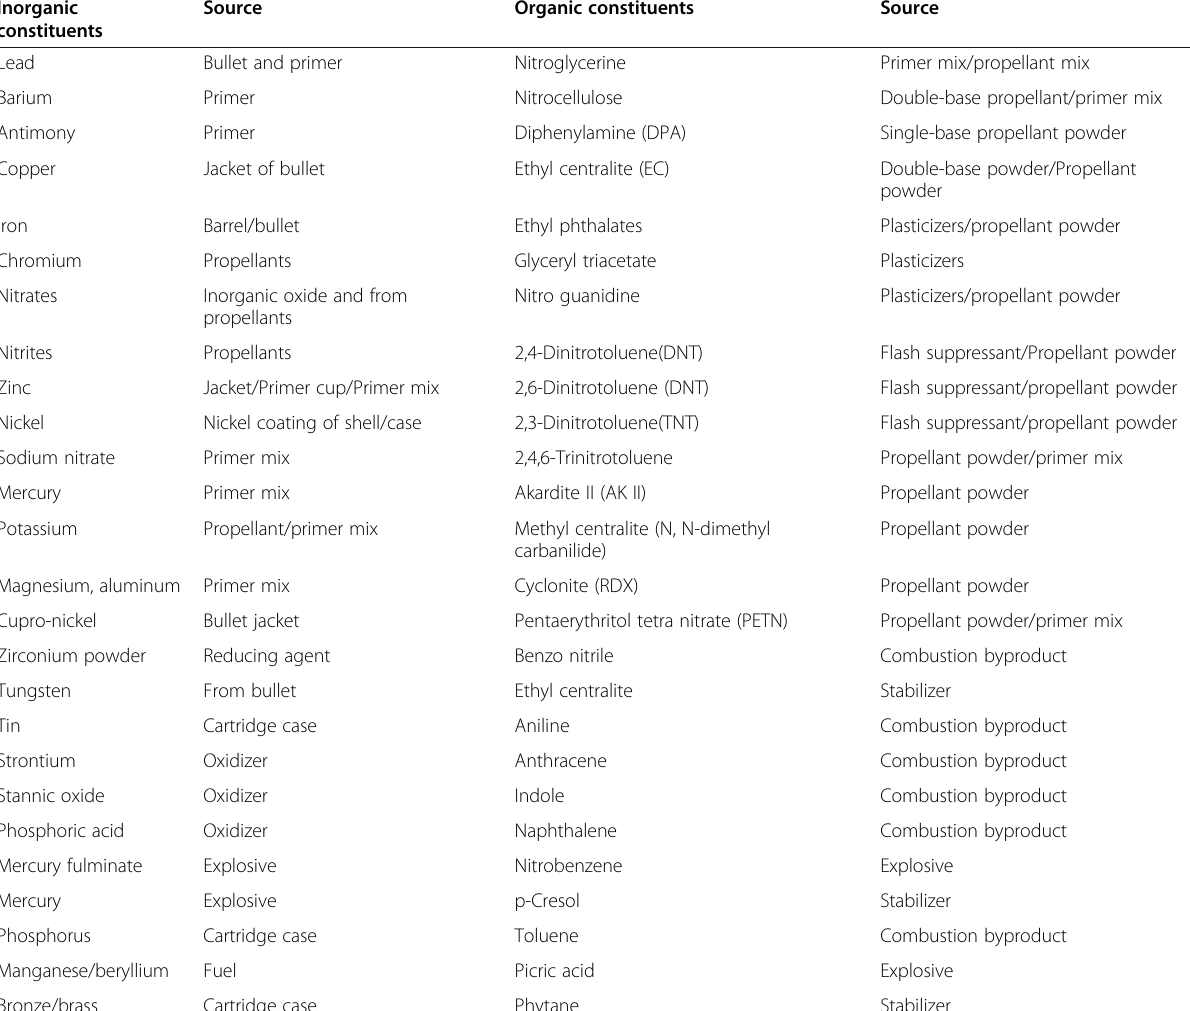
Table 1 Major inorganic (IGSR) and organic (OGSR) particle present in Gunshot Residue encountered at the SOC (scene of crime) Inorganic